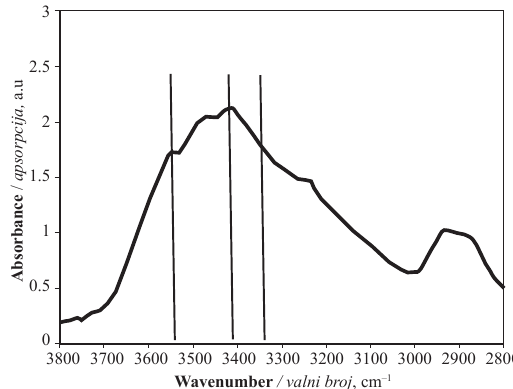
Figure 1 Assignment of hydroxyl bands in FTIR spectra for untreated Turkish red pine Slika 1 . Raspored hidroksilnih skupina na infracrvenom dijelu spektra za netretiranu piljevinu od drva turskoga crvenog